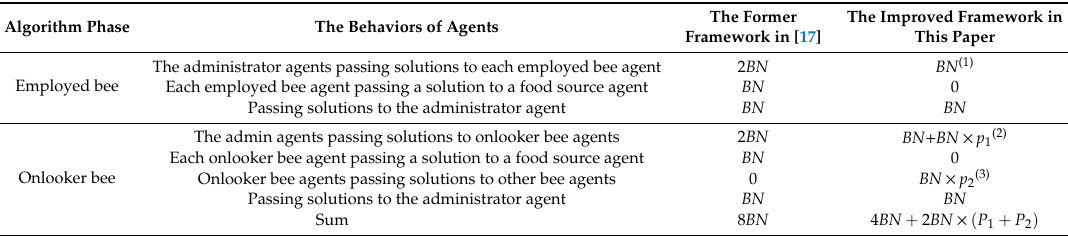
Table 2 The Number of Transferred Solutions among Agents in one Iteration. Table 2. The Number of Transferred Solutions among Agents in one